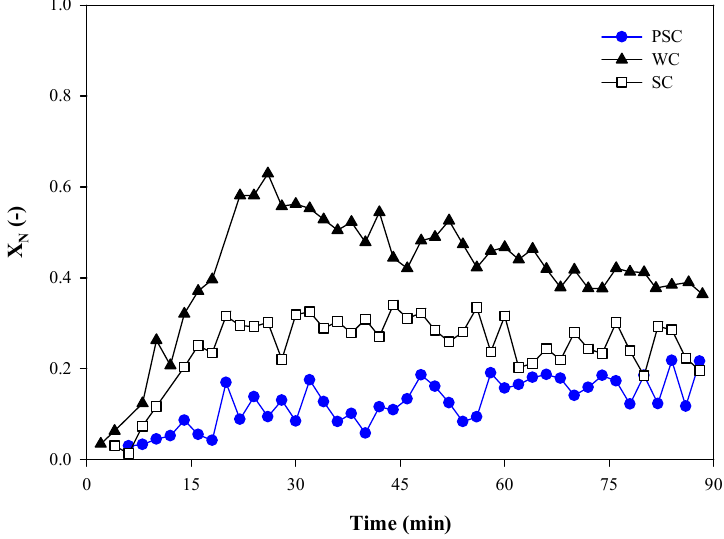
Figure 4. Naphthalene conversions during 90 min tar reforming over PSC, WC, and SC at 850 °C.